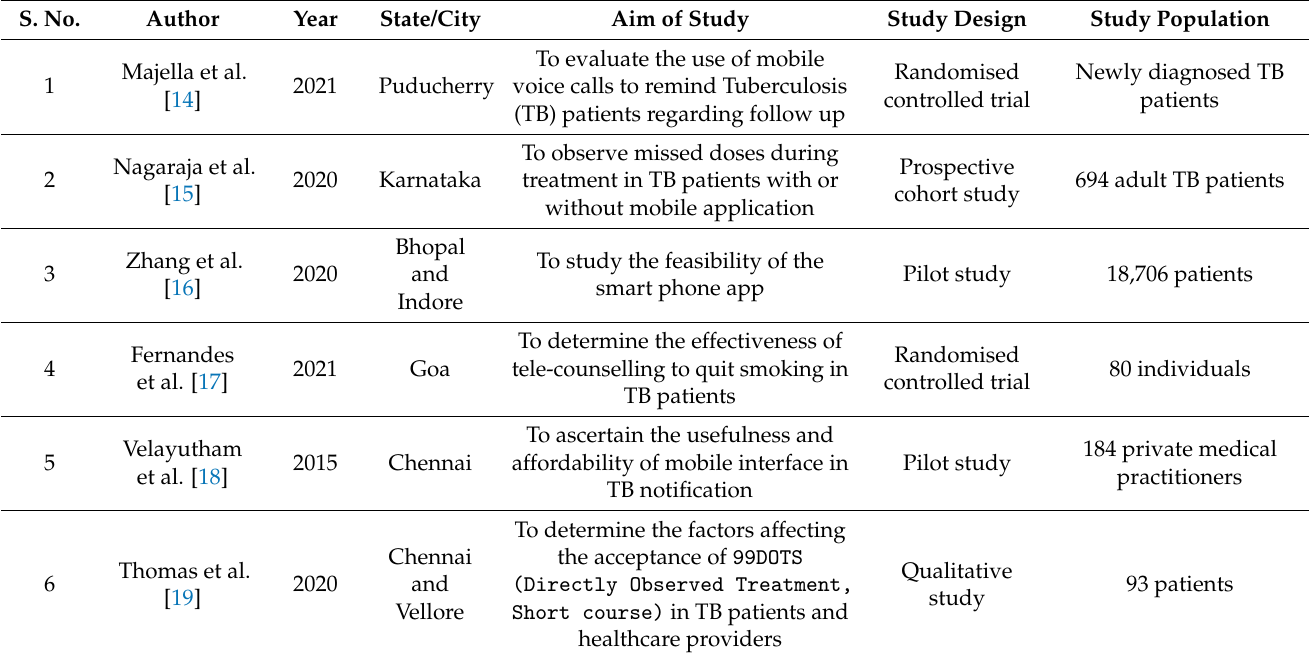
Table 2. Characteristics of the selected